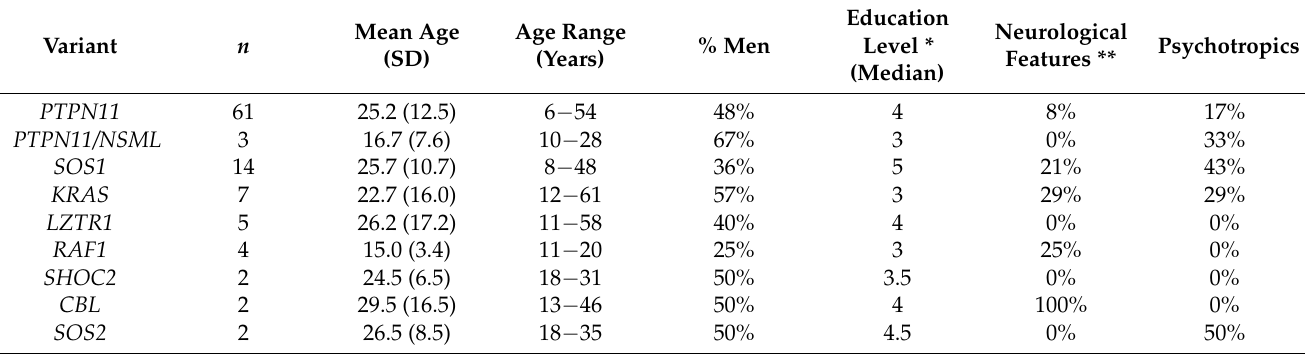
Table 2. Descriptive information of the